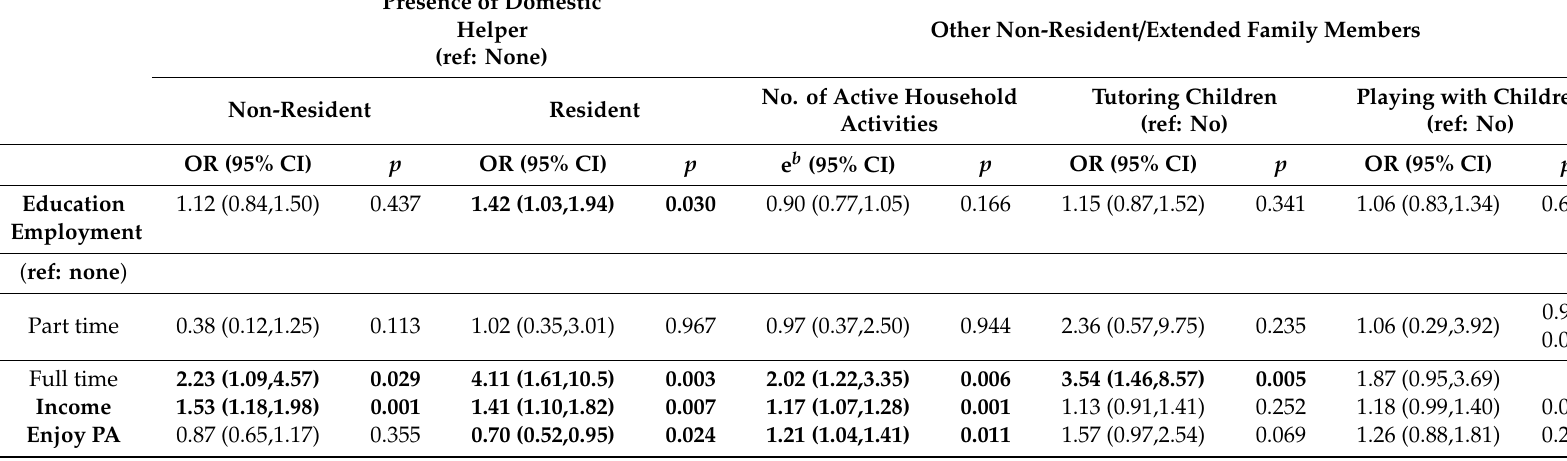
Table 4. Associations of mothers’ socio-economic status indicators with the presence of a domestic helper and household activities undertaken by other non-residents / extended family members a (Step 1 of mediation analysis). Presence of Domestic Helper Other Non-Resident / Extended Family Members (ref: None) No. of Active Household Tutoring Children Playing with Children Non-Resident Resident Activities (ref: No) (ref: No) OR (95%